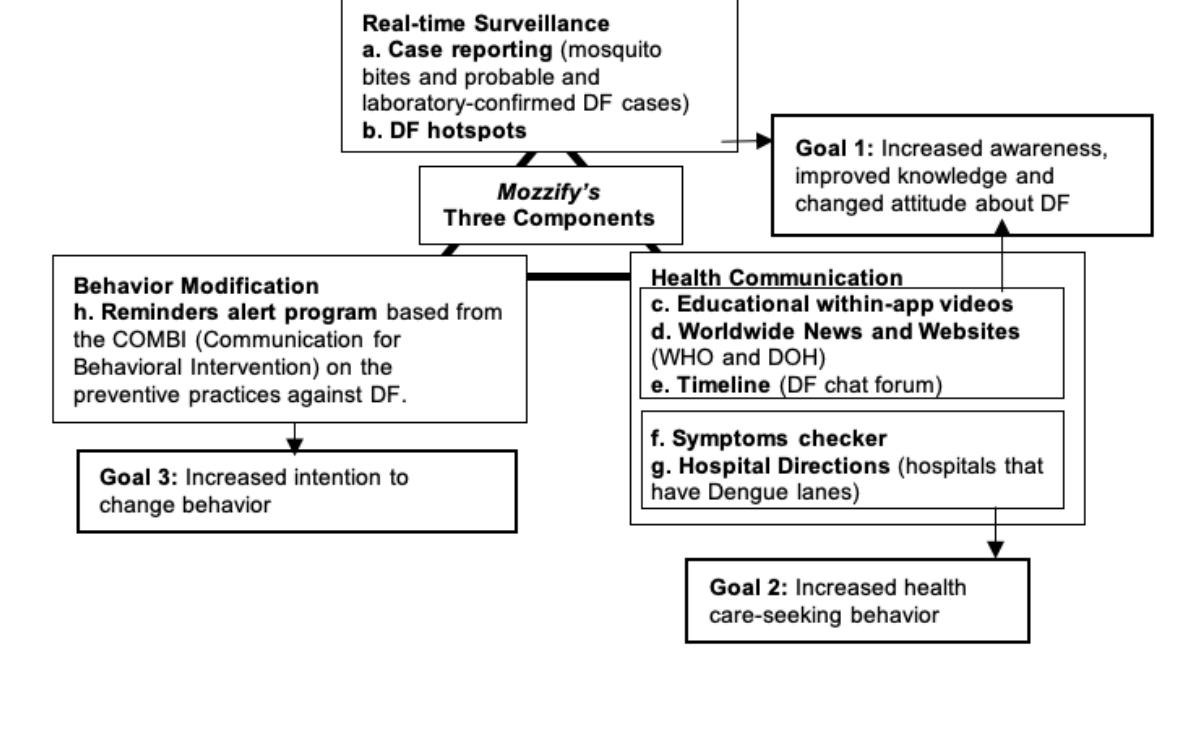
Figure 1. Mozzify’s three components with their corresponding features and goals. DF: dengue fever; DOH: Department of Health; WHO: World Health